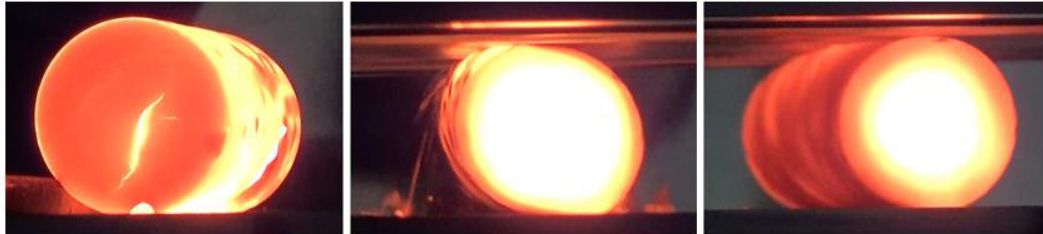
Figure 3. Rotational compression of a sample with the initial length equal 90 mm with the reduction ratio 1.15; the temperature of the billet 1150 °C.